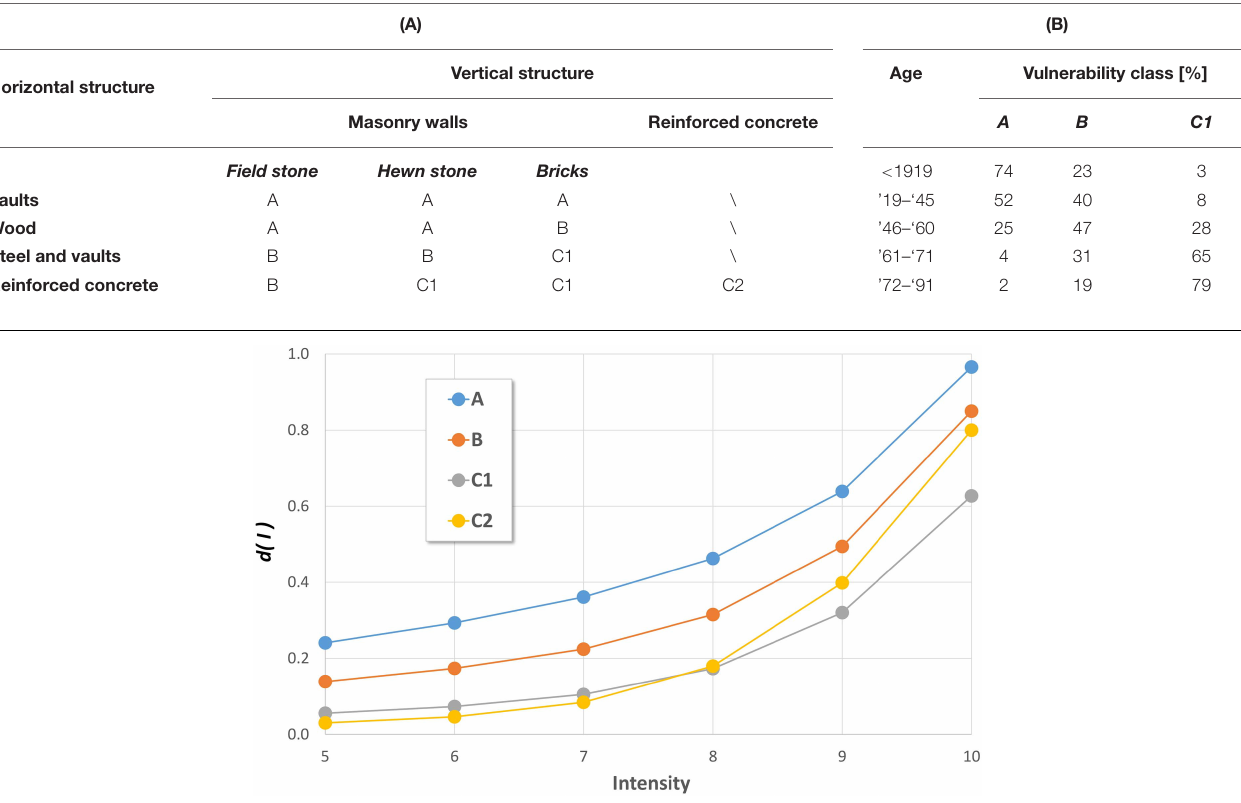
TABLE 5 | (A) Vulnerability classes vs. horizontal and vertical structural elements. (B) Vulnerability classes vs. age for masonry buildings (modified from Di Pasquale and Orsini, 1998).